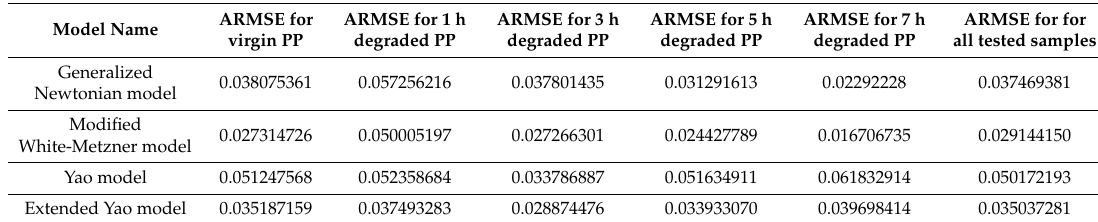
Table 6. Fitting error (average root mean squared error—ARMSE) for each utilized